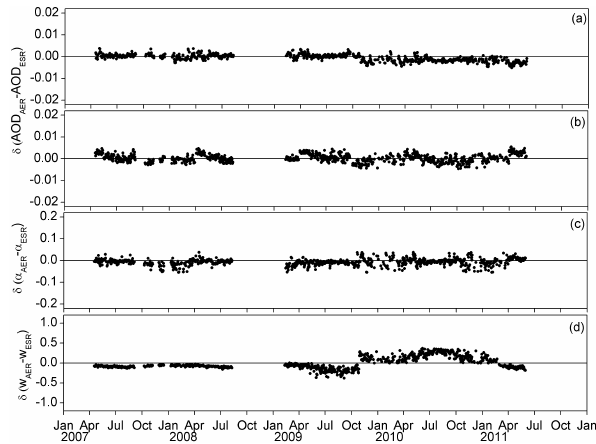
Fig. 4. Evolution of daily averaged differences between ESR- CIMEL (mode 2) and AERONET products in Burjassot during period 2007–2011: (a) AOD at 675nm, (b) AOD at 1020nm, (c) ˚ Angstr ¨ om exponent, and (d) columnar water